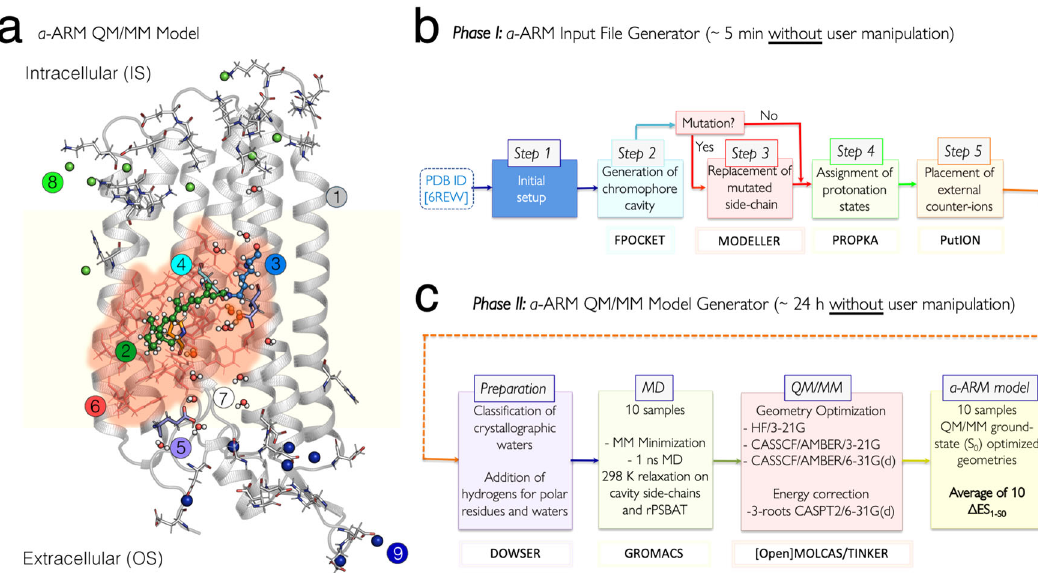
Fig. 4 Structure of a -ARM protocol. ( a ) General scheme of a monomeric, gas-phase and globally uncharged QM/MM model for the WT-KR2 rhodopsin, generated by the a -ARM rhodopsin model building protocol. This is composed of: (1) environment subsystem (silver cartoon), (2) retinal chromophore (green tubes), (3) Lys side-chain covalently linked to the retinal chromophore (blue tubes), (4) main counter-ion MC (cyan tubes), (5) protonated residues, (6) residues of the chromophore cavity subsystem (red tubes), (7) water molecules, and external (8) Cl − (green balls) and (9) Na + (blue balls) counterions. Parts 2 and 3 form the Lys-QM subsystem which includes the H-link atom located along the only bond connecting blue and green atoms. Parts 4 and 6 form the cavity subsystem. The water molecules (Part 7) may be part of the environment or cavity subsystems. The external OS and IS charged residues are shown in frame representation. The residue P219 is presented as orange tubes. (right) General work fl ow of the a -ARM rhodopsin model building protocol for the generation of QM/MM models of wild-type and mutant rhodopsins. The a -ARM protocol comprises two phases: ( b ) input fi le generator phase and ( c ) QM/MM model generator phase. The different software used in each step are also speci fi